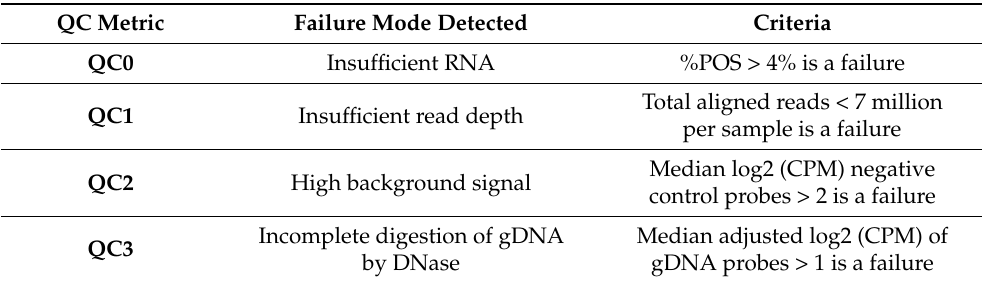
Table 1. QC plots and their meaning.